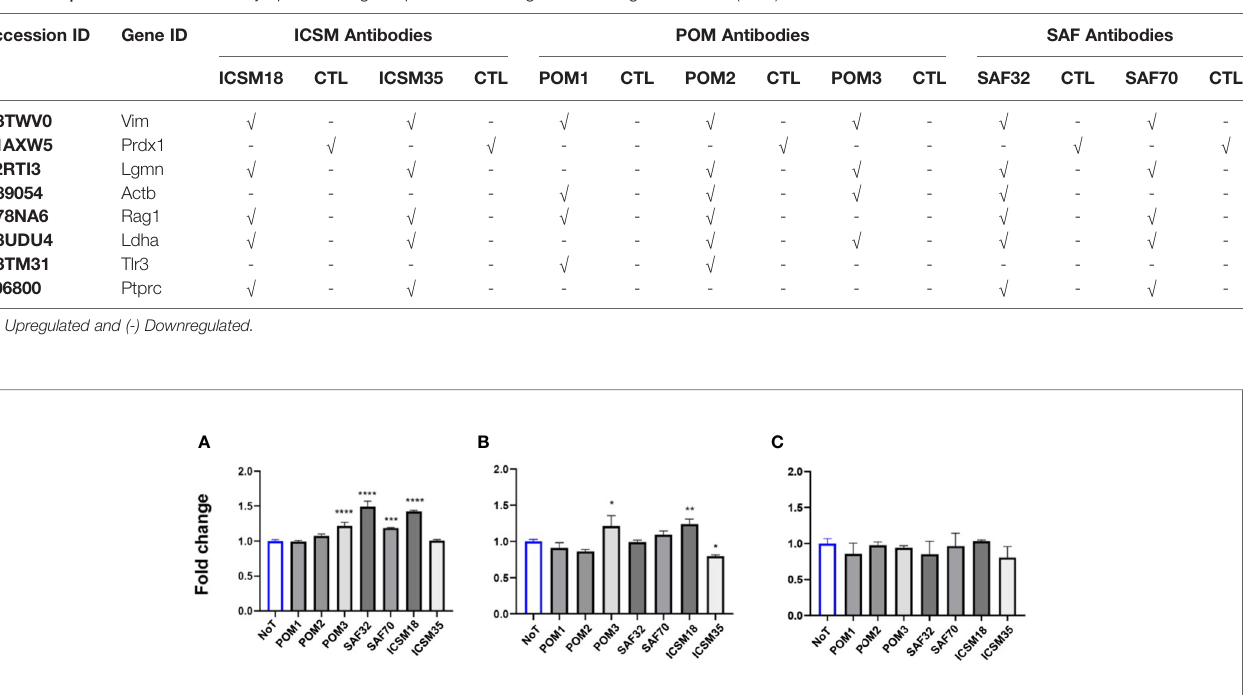
FIGURE 6 | Production of proin fl ammatory cytokines following direct microglial treatment (DMT) with anti-PrP antibody treatment of mouse neuroblastoma cell line. Herein, fold change of NO (A) , IL-6 (B) and TNF- a (C) production in N2a following DMT. * p < 0.05, ** p < 0.01, *** p < 0.001, **** p < 0.0001 vs. no treatment (NoT). P values were obtained by One-way ANNOVA followed by Tukey ’ s multiple comparisons test analysis by GraphPad Prism 8.